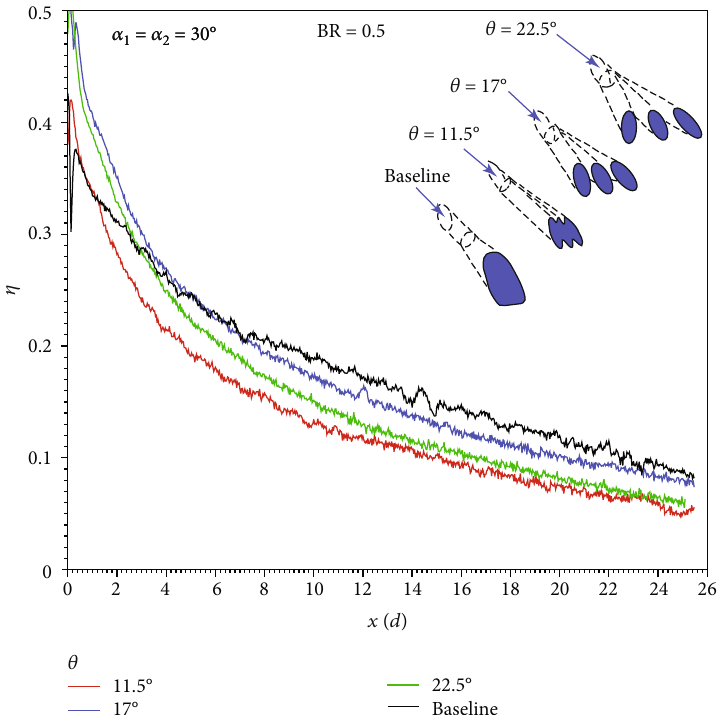
Figure 17: Streamwise (laterally averaged) fi lm e ff ectiveness variations for α BR = 0 : 5 .